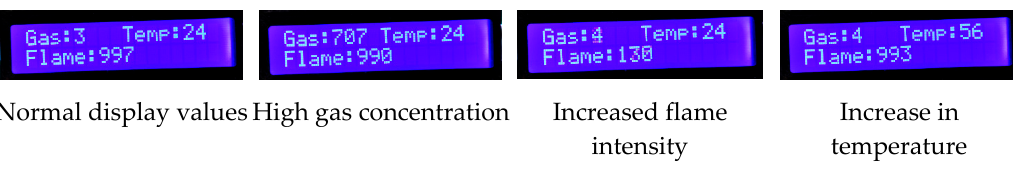
Gas notification Figure 17. Line notification messages on the mobile device.